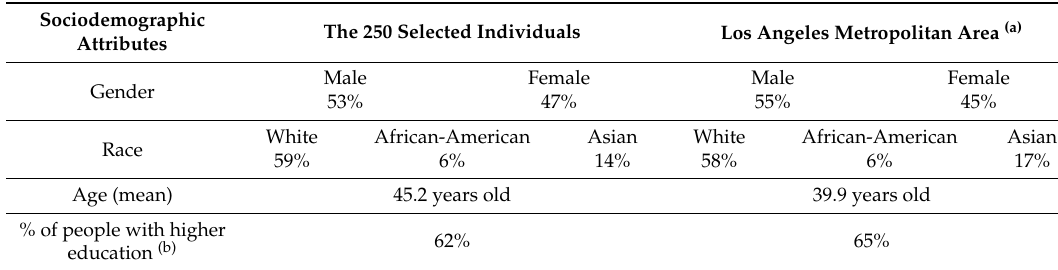
Table 1. Comparison of the sociodemographic attributes of the 250 selected participants with those of the larger population of the Los Angeles Metropolitan